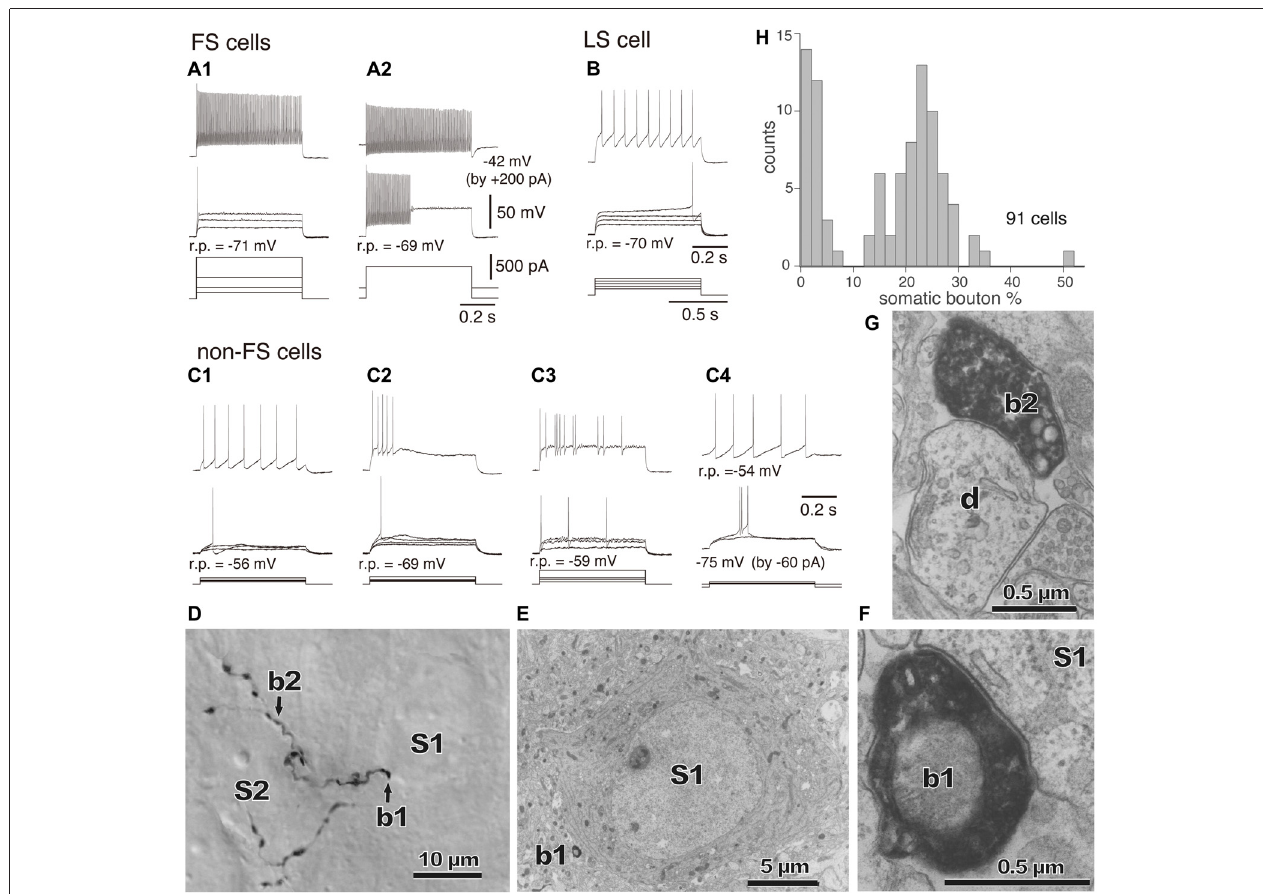
FIGURE 3 | (A–C) Firing responses of nonpyramidal cells induced by depolarizing currents. r.p., Resting potential. DC injected into neuron to change membrane potential is indicated in parentheses. (A1,A2) FS cells. (B) A LS cell. (C1–C4) Non-FS cells. (D) Boutons of an FS basket cell (b1, b2) and their appositions on unstained somata (S1, S2) observed with differential interference contrast. (E) Electron micrograph of synaptic target unstained soma (S1) of the identified bouton ( D , b1). (F) Synaptic contact of the bouton (b1) apposition on the soma (S1). (G) Electron micrographs of the bouton b2 and target dendrite (d). (H) Distribution of the somatic bouton percentage of nonpyramidal cells. Nonpyramidal cells were divided into cells with a low and high proportion of somatic boutons. Adapted from Karube et al.